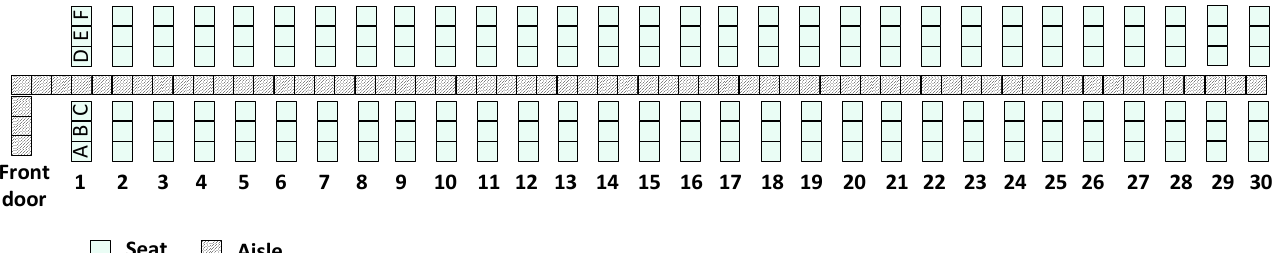
Figure 1. Airplane configuration.